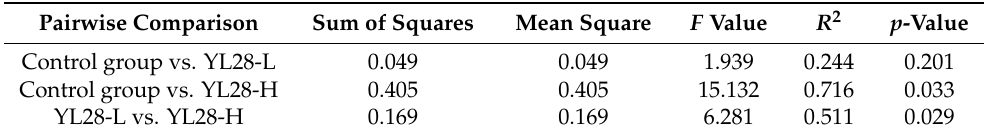
Table 3. Significance analysis between treatment groups based on Adonis (Permanova) test at genus